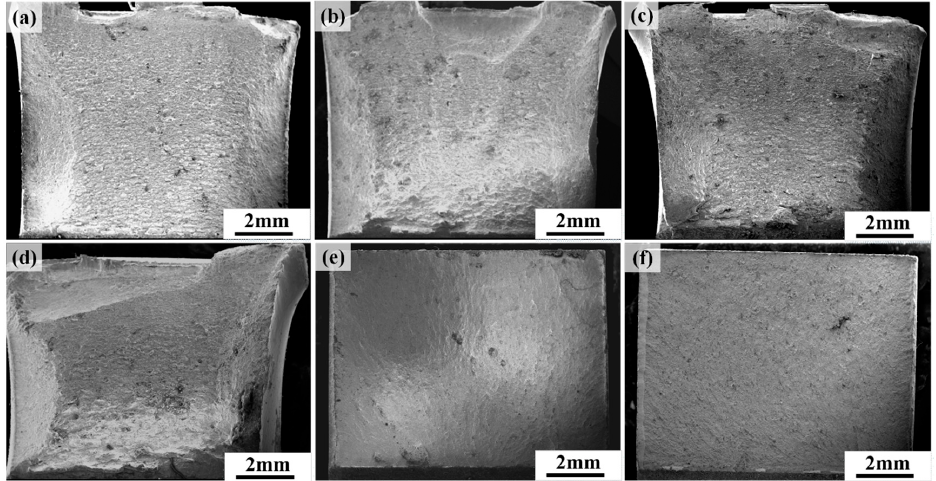
Figure 8. SEM images of macro fracture morphology of 35CrMo steel tempered at different temper- atures after Charpy impact test at room temperature: ( a ) 580 °C, ( b ) 610 °C, ( c ) 640 °C, ( d ) 680 °C, ( e ) 710 °C, and ( f ) 740 °C.